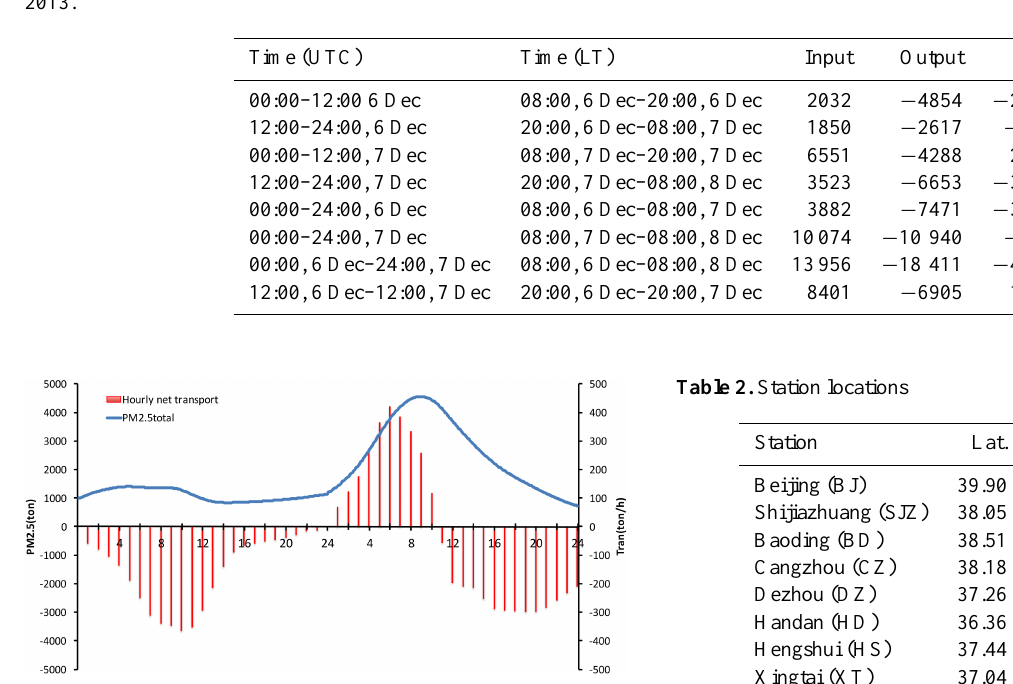
Table 1. Total input, total output and total net transport (all in tons) for the BJ area for each time period (UTC and LT) during 6–7 December 2013.